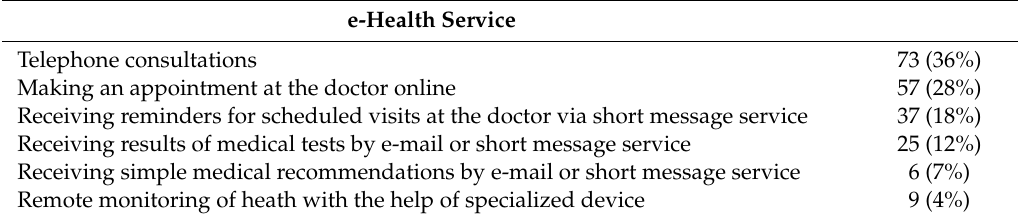
Table 1. Selected preference for the e-Health services among the